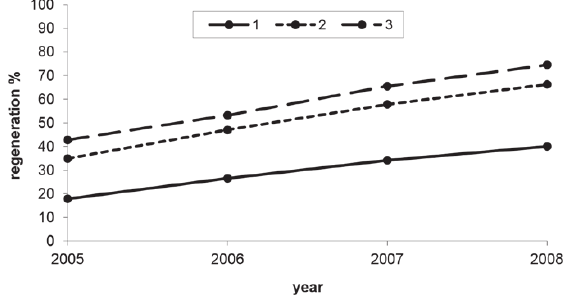
Figura 3 - Bark regeneration of Drimys brasiliensis under different amounts of exploited strips (1, 2 and